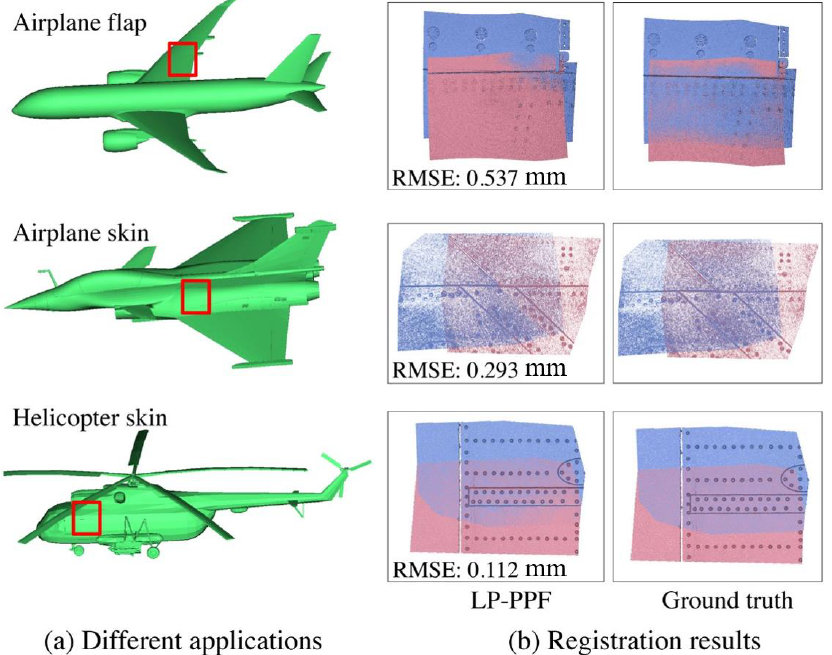
Figure 10. The pairwise registration results on aerospace applications [149]. ( a ) Different applications including airplane flap, airplane skin, and helicopter skin. ( b ) The registration results of different types of point clouds.